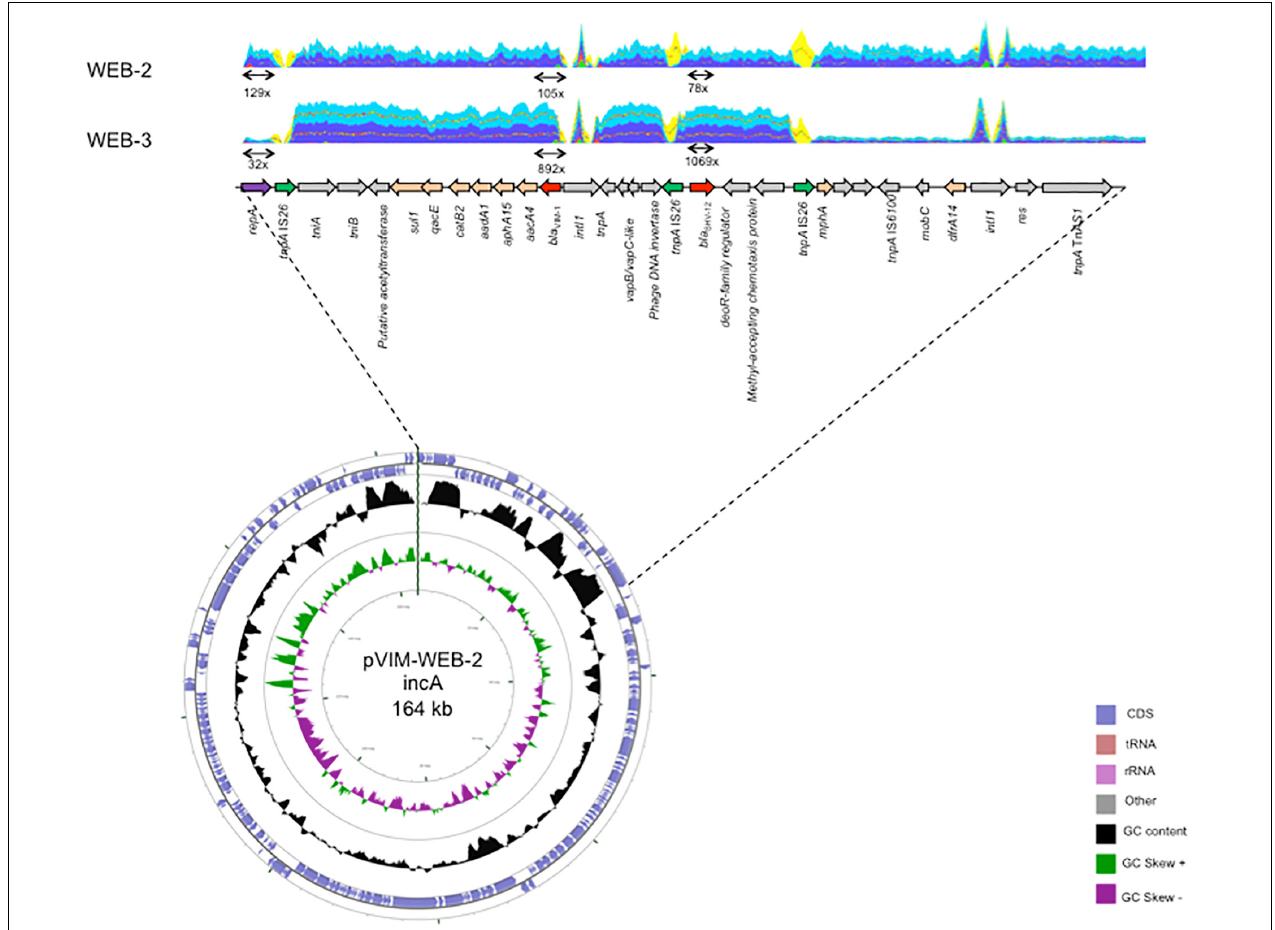
FIGURE 1 | Schematic representation of the p(WEB-2) plasmid and the structure carrying the bla VIM − 1 carbapenemase gene in A. hermannii WEB-2 and WEB-3. Open reading frames are indicated by arrows. Gene coverage was indicated at scale with the genetic organization. Gene coverage is indicated on selected features and determined using Illumina read